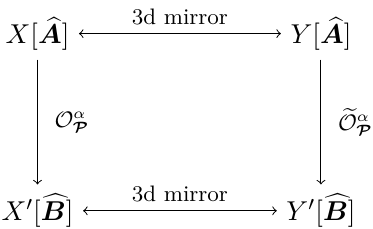
Figure 1 . Generating new dual pairs using an elementary S -type